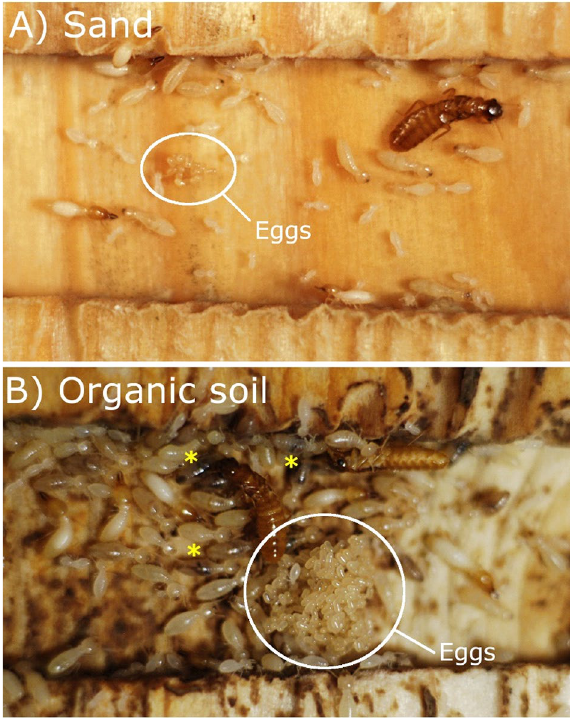
Figure 4. Photographs of the most successful C. formosanus 20 month-old colonies (partial view including the egg mass) when kept in a container with access to wood and ( A ) sand, or ( B ) organic soil, for a period of 6 months. *Examples of termites with dark organic soil visible in the gut.